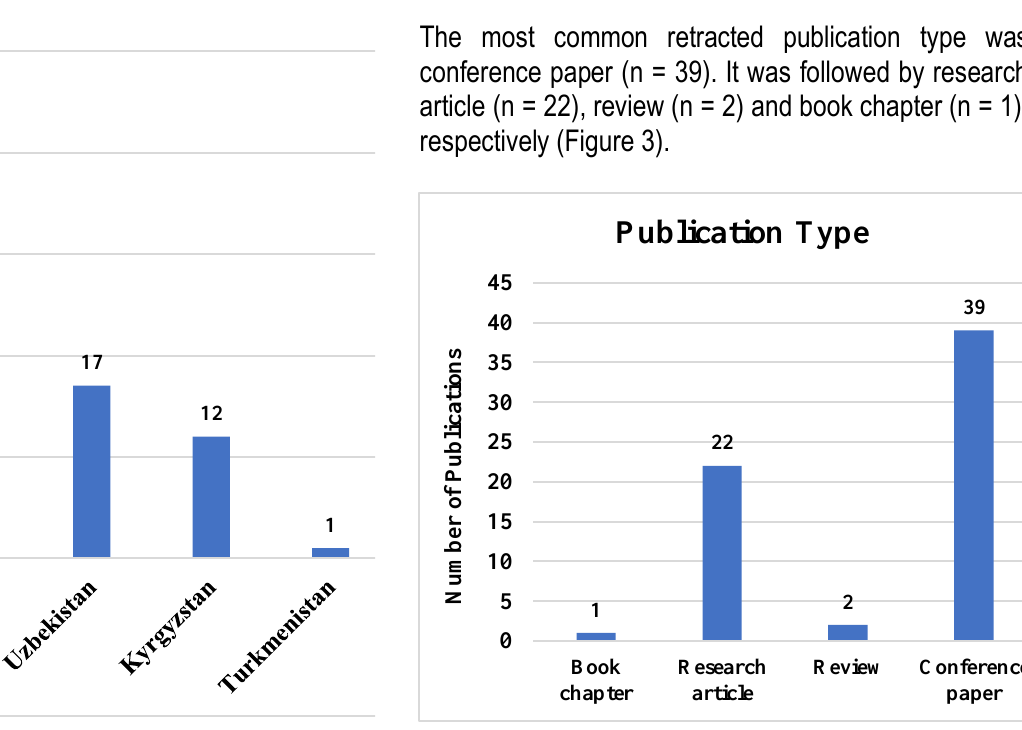
Figure 1. Number of retracted publications among the Central Asian countries